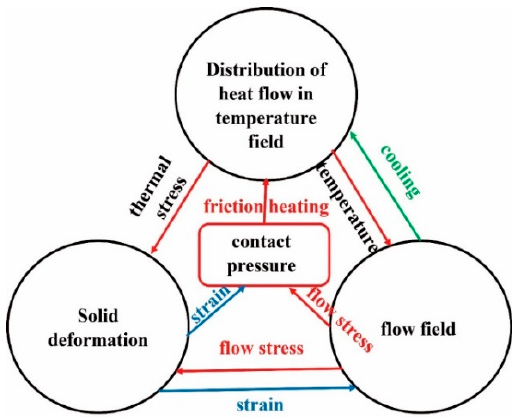
Figure 4. Multi physical field coupling diagram of the disc brake.